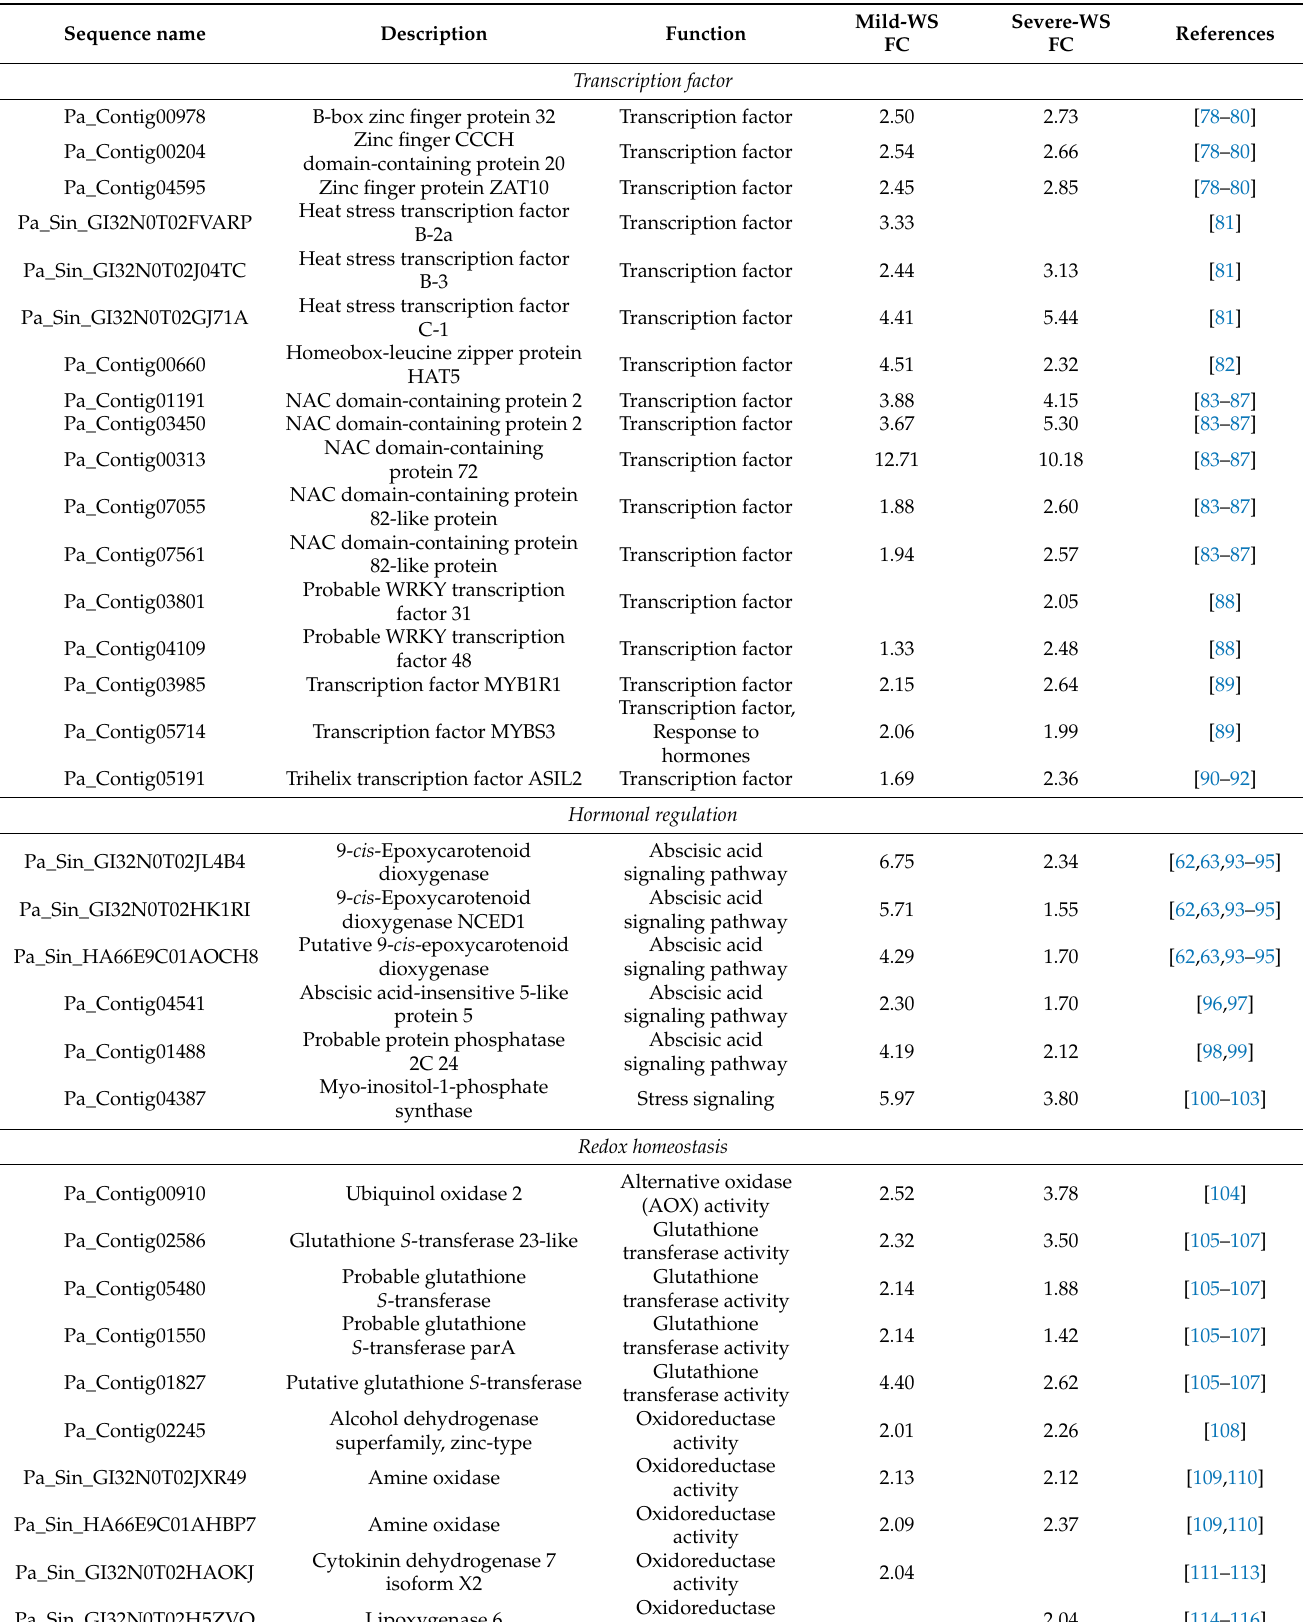
Table 4. Water stress-related differentially expressed genes (DEGs) from ‘Dusa’ avocado rootstocks subjected to two different levels of water stress: mild-WS (50% of Fc) and severe-WS (25% of Fc) (FC, fold